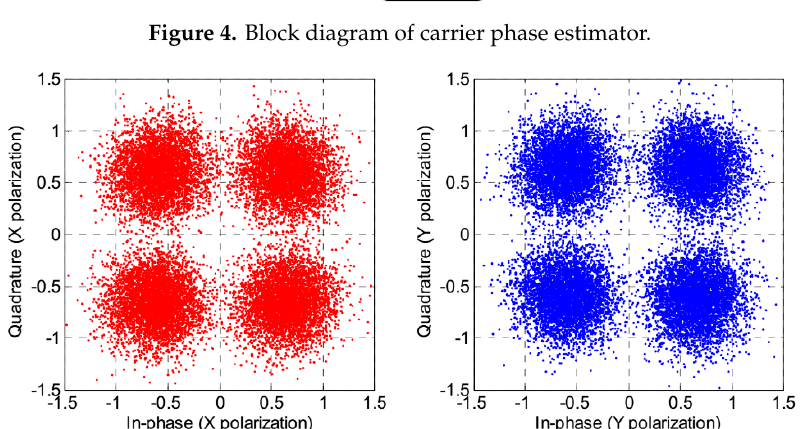
Figure 5. Recovered constellation diagrams for the two polarizations after 6400 km transmission with an estimated BER = 2.4 × 10 − 3 .